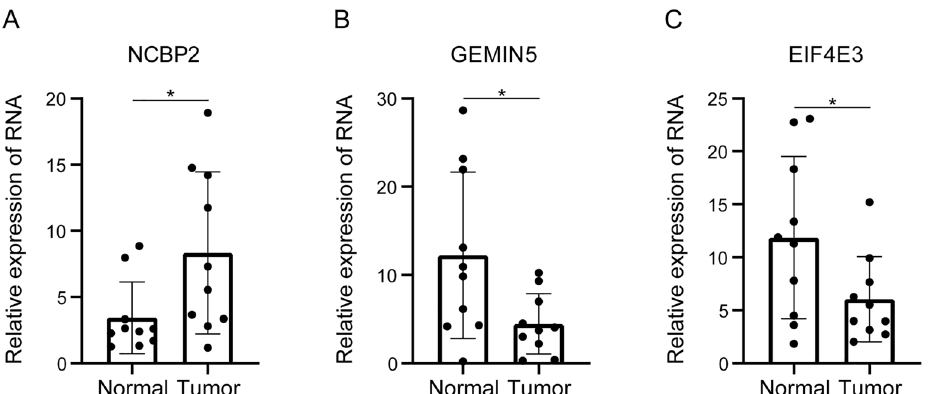
Figure 7. qRT-PCR validation of m 7 G-related gene expression. ( A – C ) qRT-PCR analysis of NCBP2, GEMIN5, and EIF4E3 expression in 10 groups of CRC tissues and paraneoplastic tissues. *P < 0.05; **P < 0.01; ***P <